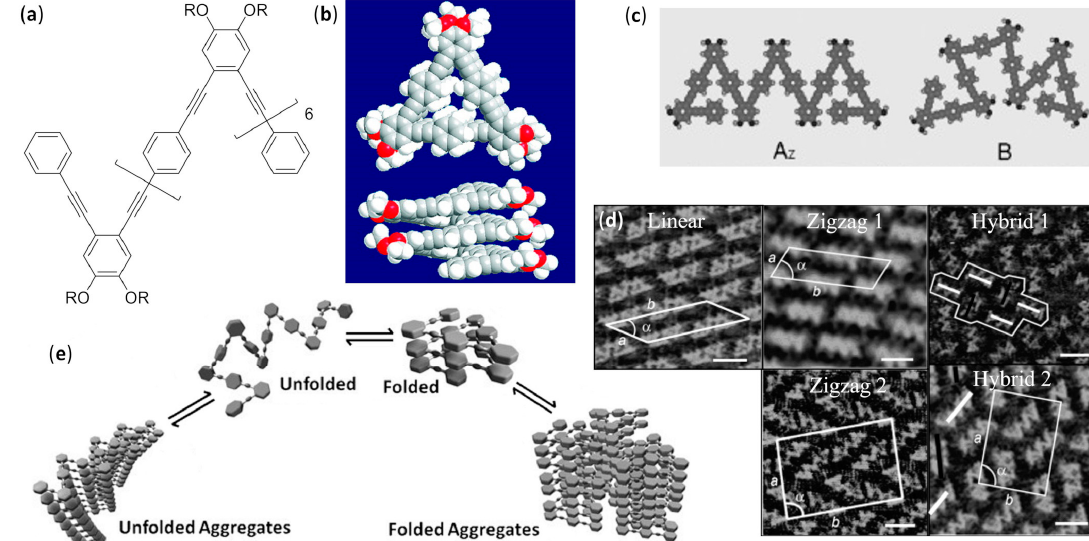
Figure 13. ( a ) Chemical structure of o -phenyleneethynylene- alt - p -phenyleneethynylene (OPE) foldamers (Refs. [170–173]); ( b ) Secondary structure of a pentadecameric OPE foldamer with R = n -dodecyl (dodecyl side chains truncated as methyl groups) (adapted with permission from Ref. [170]); ( c ) A Z and B foldings of OPE with R = n -dodecyl (side chains omitted for clarity) and ( d ) STM images of their self-association in different conditions of solvent and concentration (zigzag 1 in TCB, zigzag 2 in 1-phenyloctane and tetradecane, hybrid 1 in heptanoic acid, hybrid 2 in 1-phenyloctane and tetradecane, linear in heptanoic acid, 1-phenyloctane, and tetradecane; scale bars: 4 nm) (adapted with permission from Ref. [171]); ( e ) Representation of equilibria involved in single molecules and aggregates of OPE foldamers (see text for explanations) (adapted with permission from Ref.